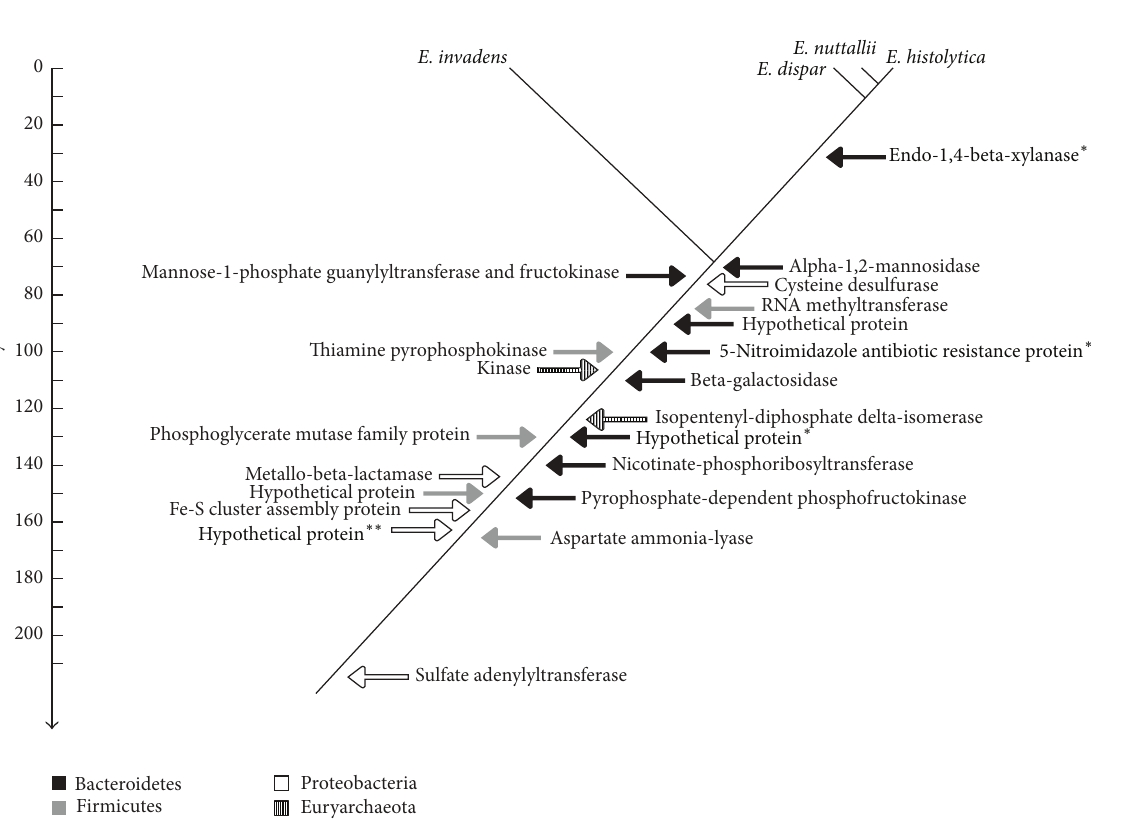
Figure 3: Divergence times of Entamoeba species, as well as horizontal transfers events. The units are Map (million years ago). ∗ Genes without counterparts in the genome of E. invadens . ∗∗ No homologous genes in the genome of E. dispar